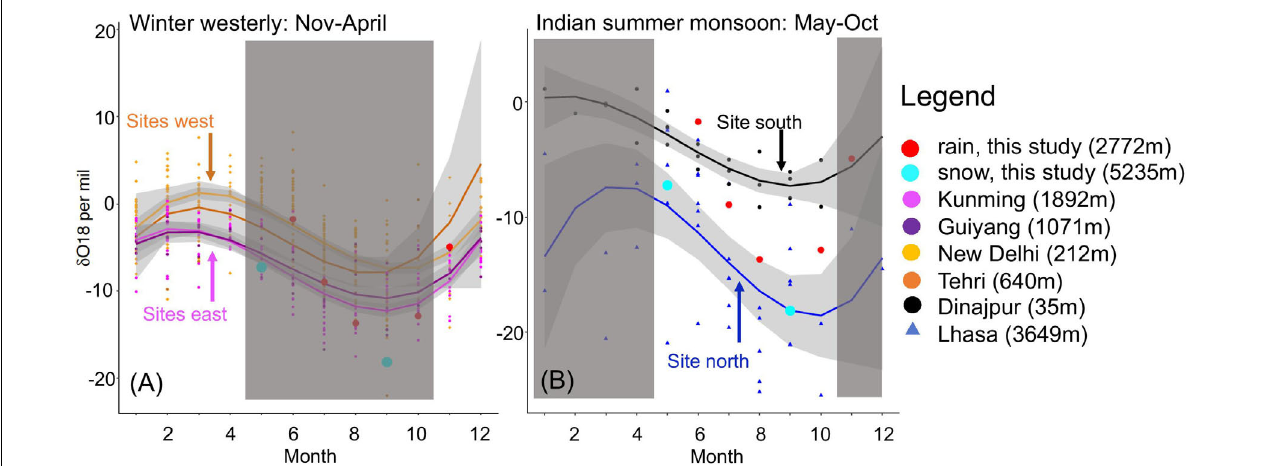
FIGURE 6 | Global Network of Isotopes in Precipitation (GNIP) monthly isotope records for sites along the prevailing weather transects relative to the subject site ( Figure 2 ). The westerly flow (A) is prevalent from November to April and the transect captures sites west and east of the Chamkhar Chhu. The Indian monsoon (B) dominates moisture paths from May to October, with the transect perpendicular to the Himalaya. Light gray shading is the 95% confidence level interval. Months not applicable to each season are covered by dark gray